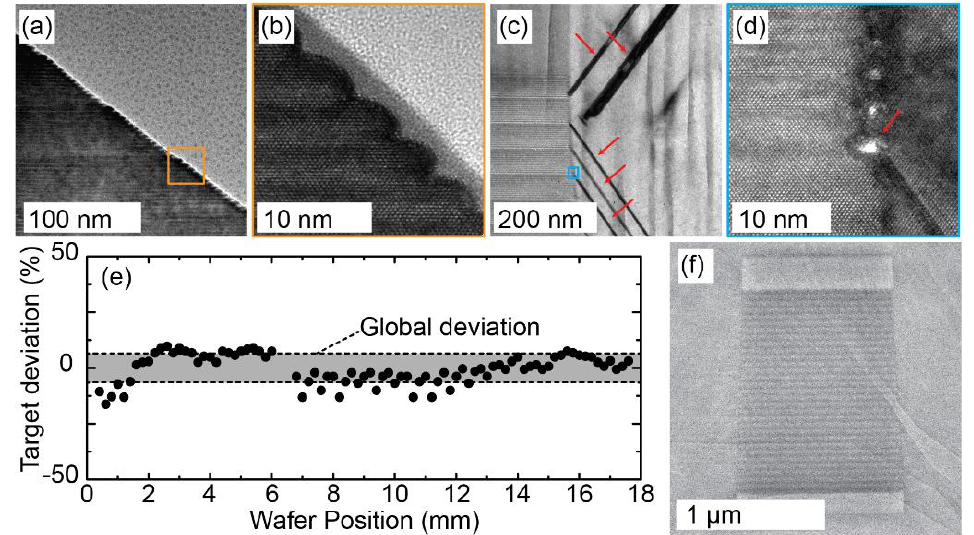
Figure 3. Analysis of waveguide definition. ( a ) TEM micrograph depicting the sidewall of an etched active region; and ( b ) high-resolution TEM showing a detail marked with an orange box in ( a ). ( c ) Dark-field TEM image depicting stacking faults (red arrows) originating at the interface between the active region and the lateral MOVPE regrowth; ( d ) high-resolution TEM showing a zoom to a stacking fault marked with a blue box in ( c ). The red arrow highlights the stacking fault nucleation site; ( e ) deviation from the target active waveguide width as a function of position on the wafer; and ( f ) cross-sectional SEM micrograph of a ~1 µm wide buried active waveguide; ( a – d ) are data retrieved from standard process samples; ( e , f ) from optimized process samples.